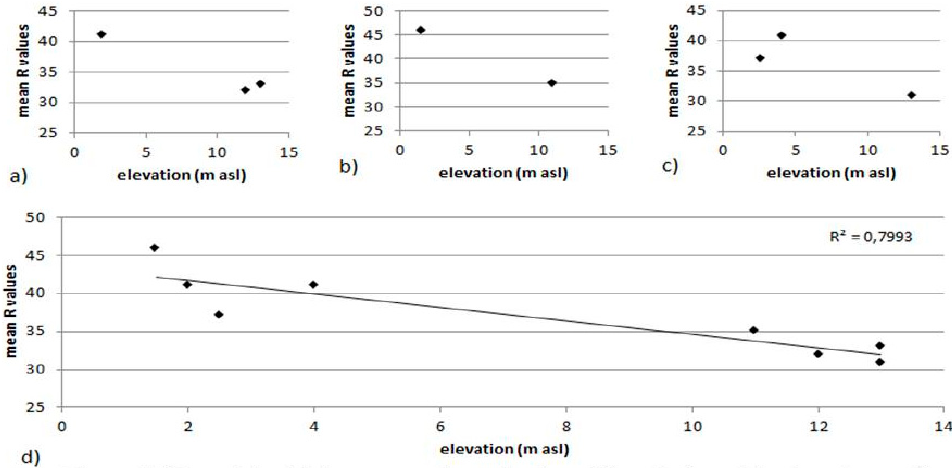
Figure 5. Mean Schmidt hammer rebound values ( R ) variation with elevation a.s.l. for localities considered in Section 4.1: ( a ) Castello Cirlo; ( b ) Villa Baldini; ( c ) Villa Beatrice; ( d ) a cumulative plot of the three localities together.